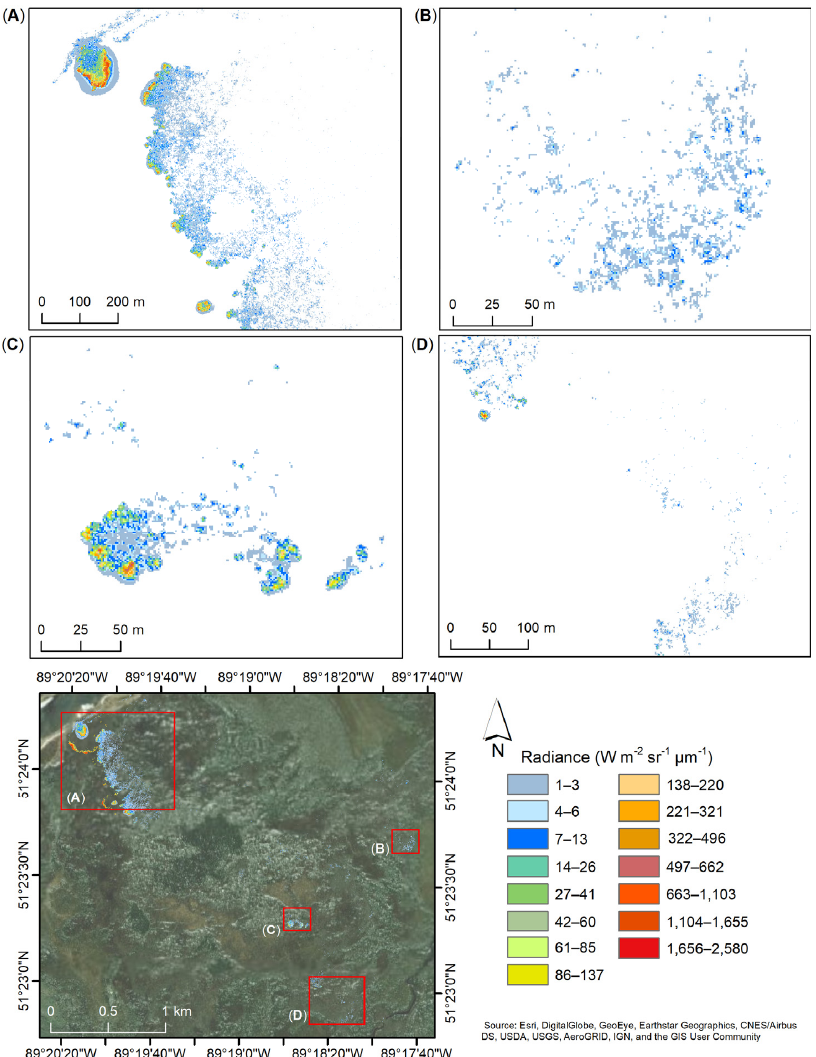
Figure 12. Radiance (Wm − 2 sr − 1 µm − 1 ) captured during the nighttime flight, F-03, acquired on 2 August 2017, over four different area ( A – D ) of the SLK-37 site. Radiance of the 1.4 ms, 0.3 ms, 0.04 ms, and 0.0021 ms integration times superimposed based on the set thresholds (Section 3.3). Radiance below 1 Wm − 2 sr − 1 µm − 1 (white) not displayed.